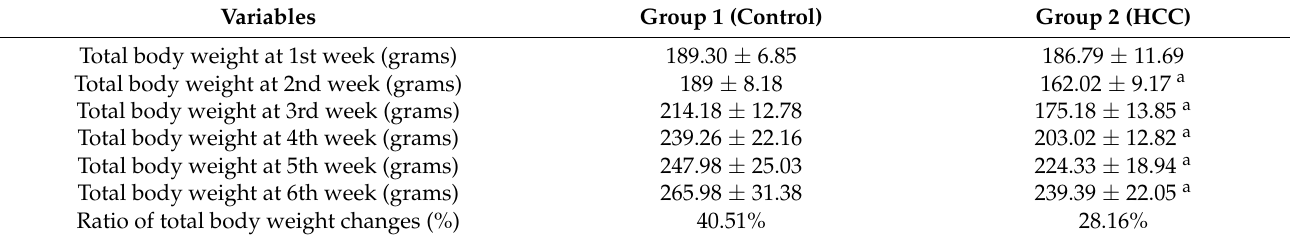
Table 1. Body weight (grams) and ratios of body weight changes (%) during 6 weeks after HCC induction in different studied